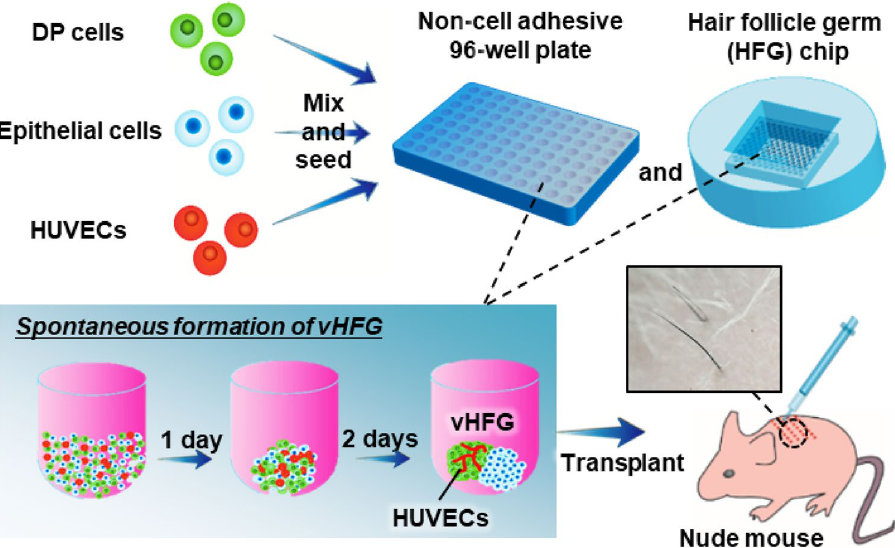
Figure 1. Preparation of vHFGs through self-organization. Human DP cells, murine fetal skin-derived epithelial cells, and HUVECs were mixed and seeded in a non-cell-adhesive 96-well plate and lab-created HFG chip. In each culture vessel, the cells formed single aggregates in the microwells, wherein the three types of cells were randomly distributed after 1 day of culture and spontaneously formed vHFGs in the following 2 days of culture. vHFGs were then transplanted into the dorsal skin of nude mice to evaluate hair regeneration